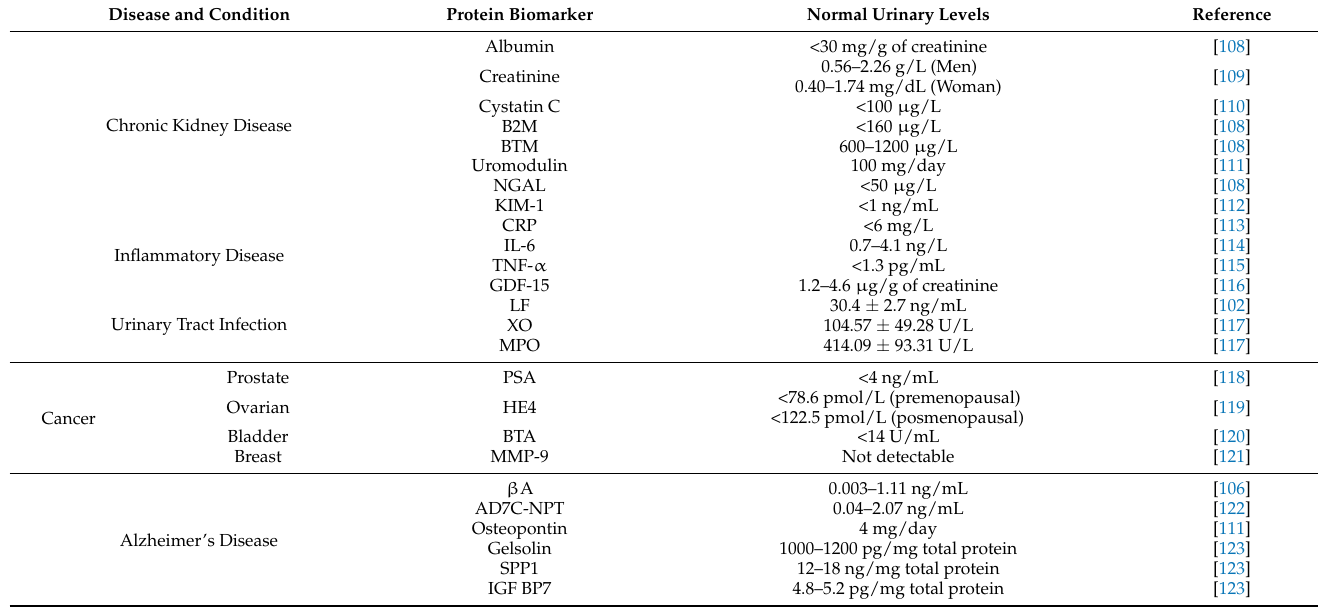
Table 1. Summary of the protein biomarkers identified and their normal urinary